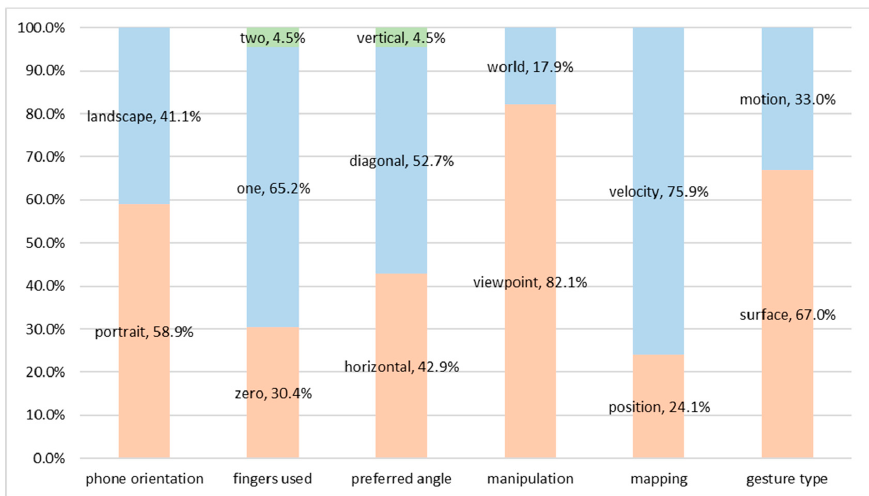
Figure 6. The taxonomy distribution of the elicited gestures.